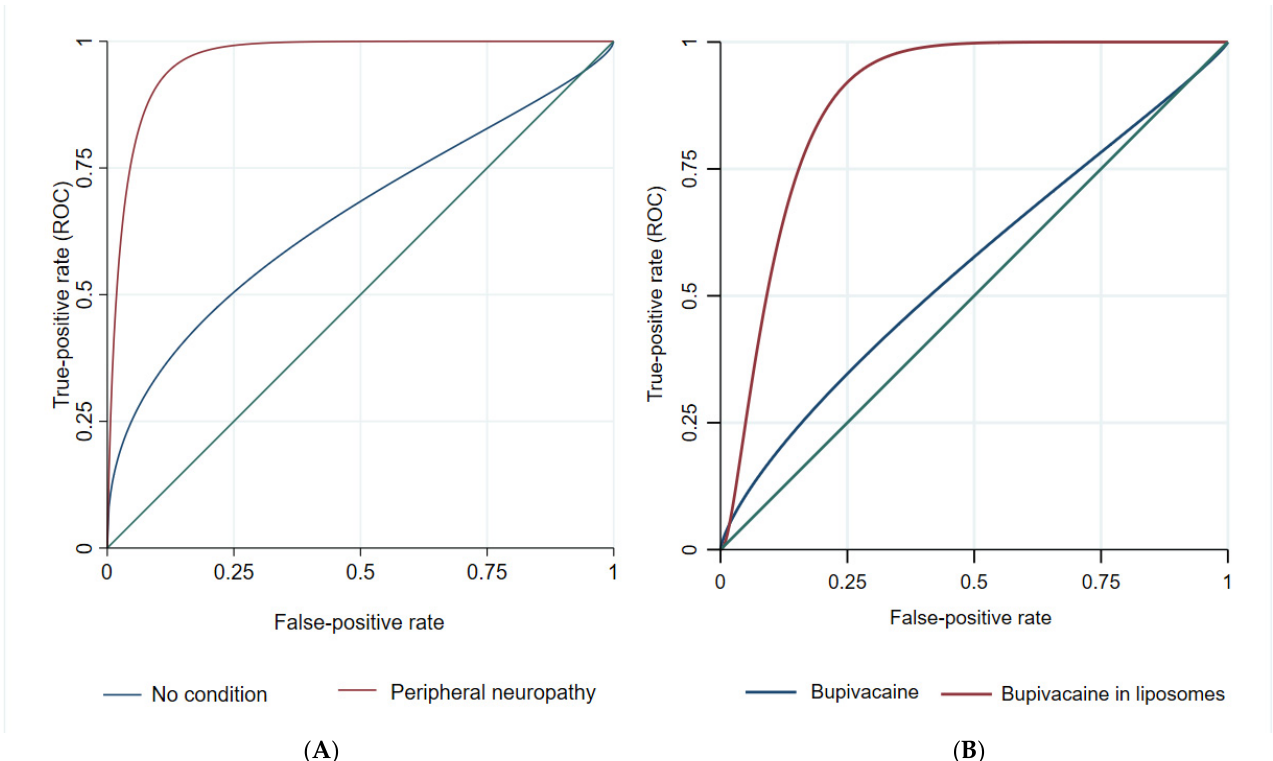
Figure 2. ( A ) The relationship between % MPE and probability of correctly classifying mice treatment based on the type of condition. ( B ) The relationship between % MPE and probability of correctly classifying mice condition based on the type of local anesthetics. Table 2. Differences between model predictions based on the duration pattern of different types of local anesthetics and different animal model